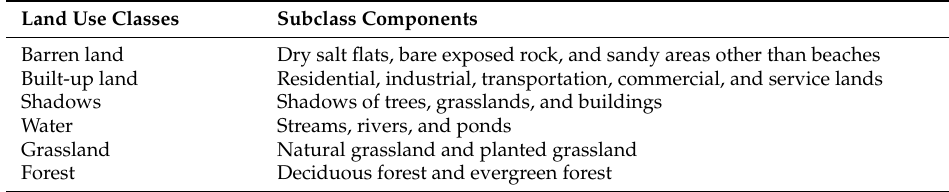
Table 1. Urban land use classes and corresponding subclass components.